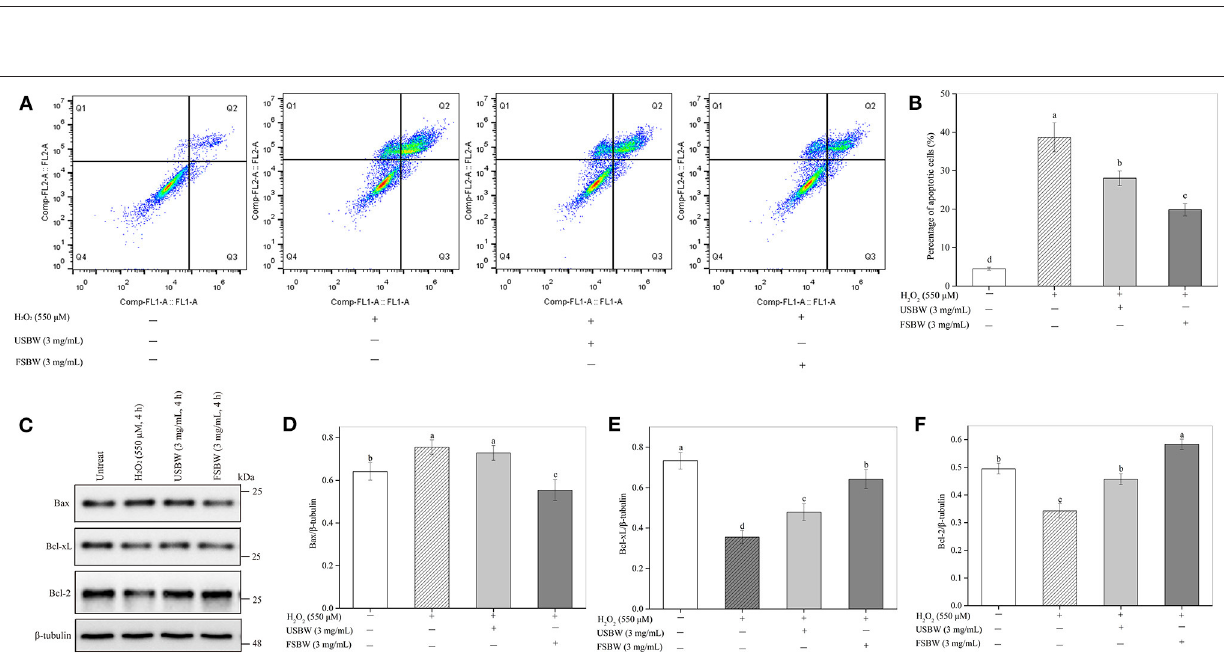
FIGURE 4 | Influence of the USBW and FSBW extracts on H 2 O 2 -induced cell apoptosis. (A) Cell apoptosis detected using a flow cytometer; (B) Statistical histogram in (A) ; (C) Bcl-xL, Bax, and Bcl-2 levels; (D–F) Statistical histogram in (C) . p < 0.05 was considered as the significant level. The small letters were used to indicate the significant difference and the ordering of